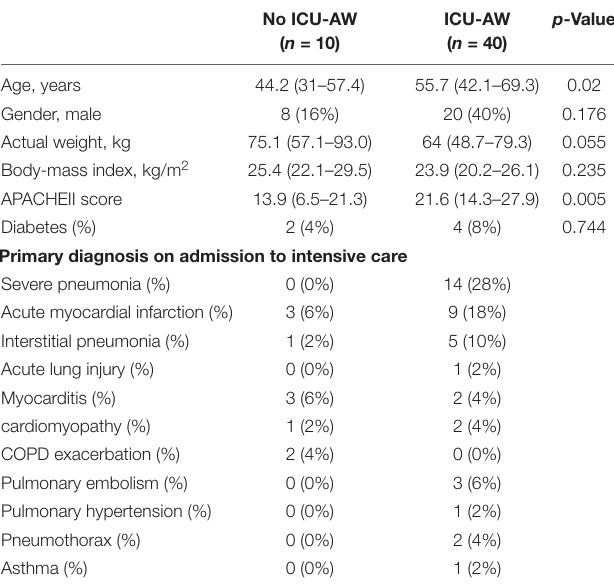
TABLE 1 | Baseline characteristics of the study population.